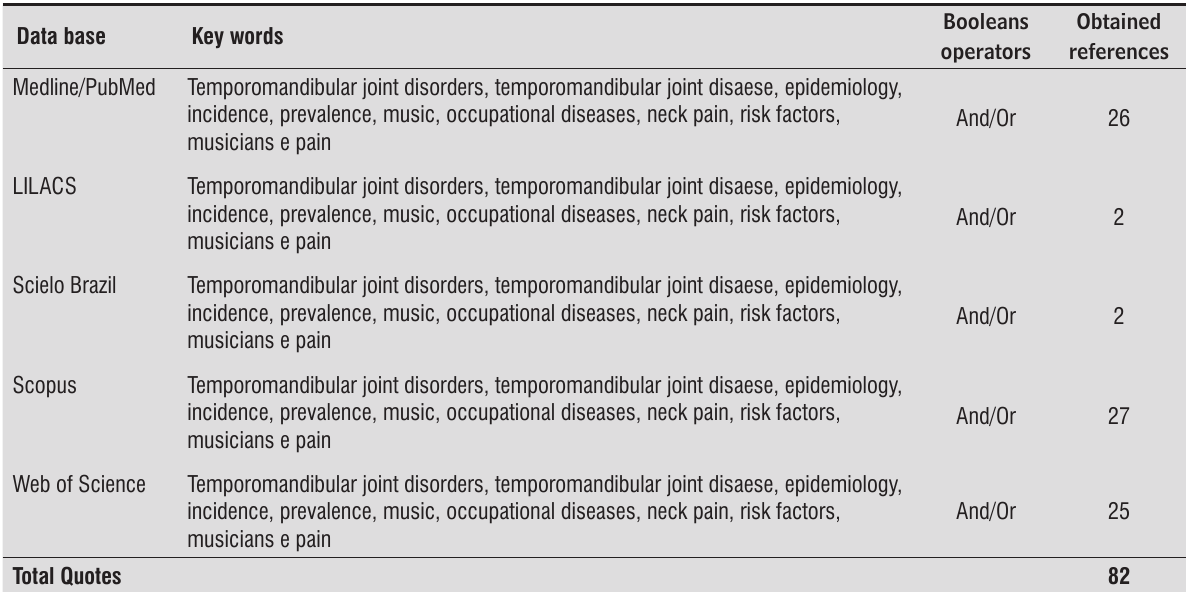
Table 1 - Search strategy in electronic databases, Brasilia, 2016 Data